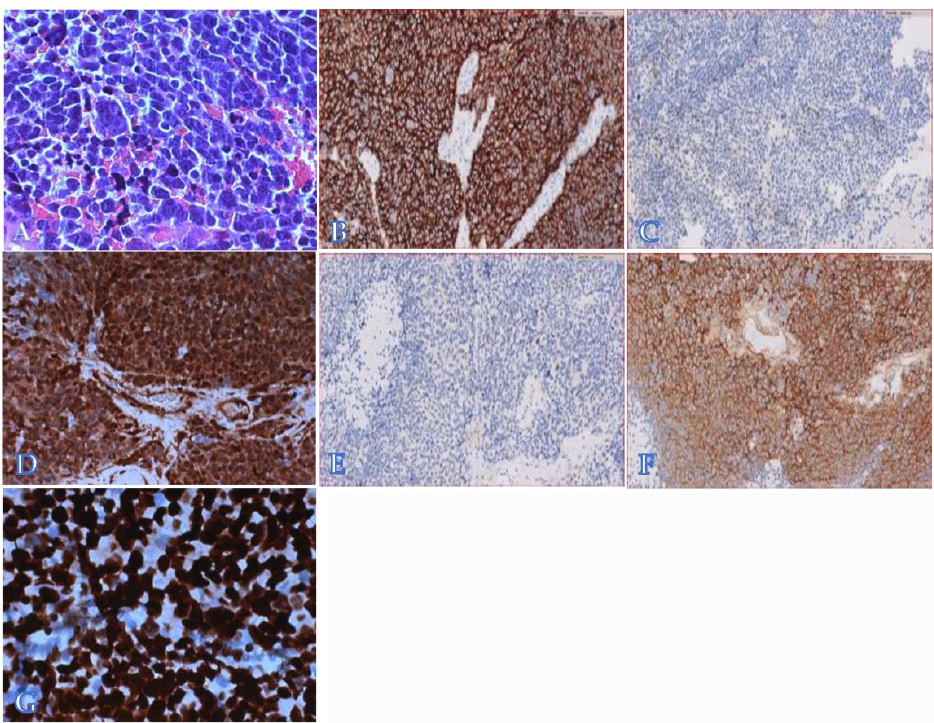
Figure 2. Histologically, the tumor consisted of sheath of cells with areas of anaplasia ( A ). The tumor showed diffuse expression of synaptophysin ( B ) and isolated NeuN-positive cells ( C ); YAP1 was diffusely positive ( D ), whereas GAB1 was negative ( E ). Beta-catenin expression was exclusively cytoplasmatic ( F ). TP53 was expressed by the majority of cells ( G ).